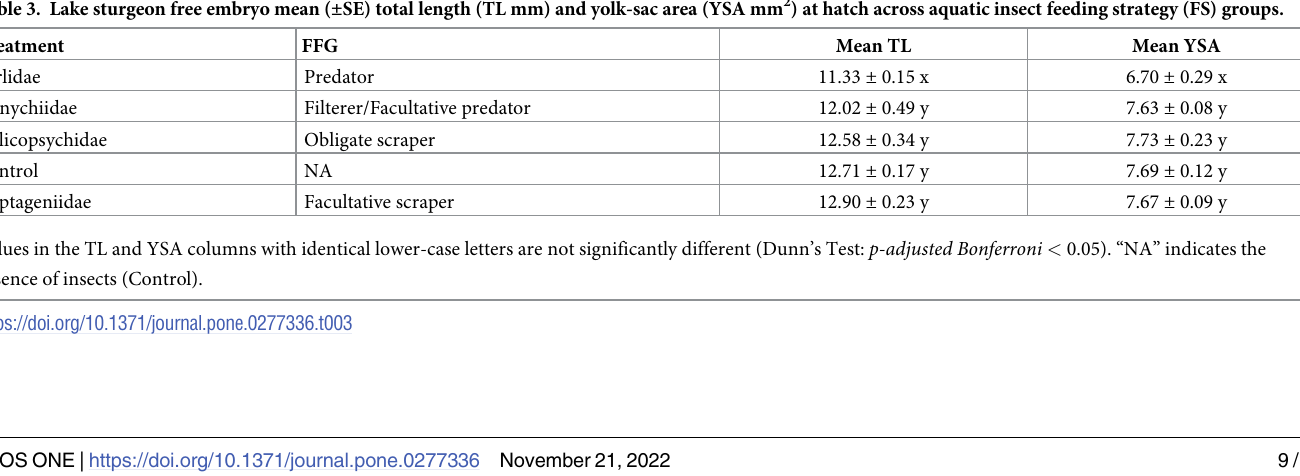
Table 3. Lake sturgeon free embryo mean ( ± SE) total length (TL mm) and yolk-sac area (YSA mm 2 ) at hatch across aquatic insect feeding strategy (FS) groups. Treatment